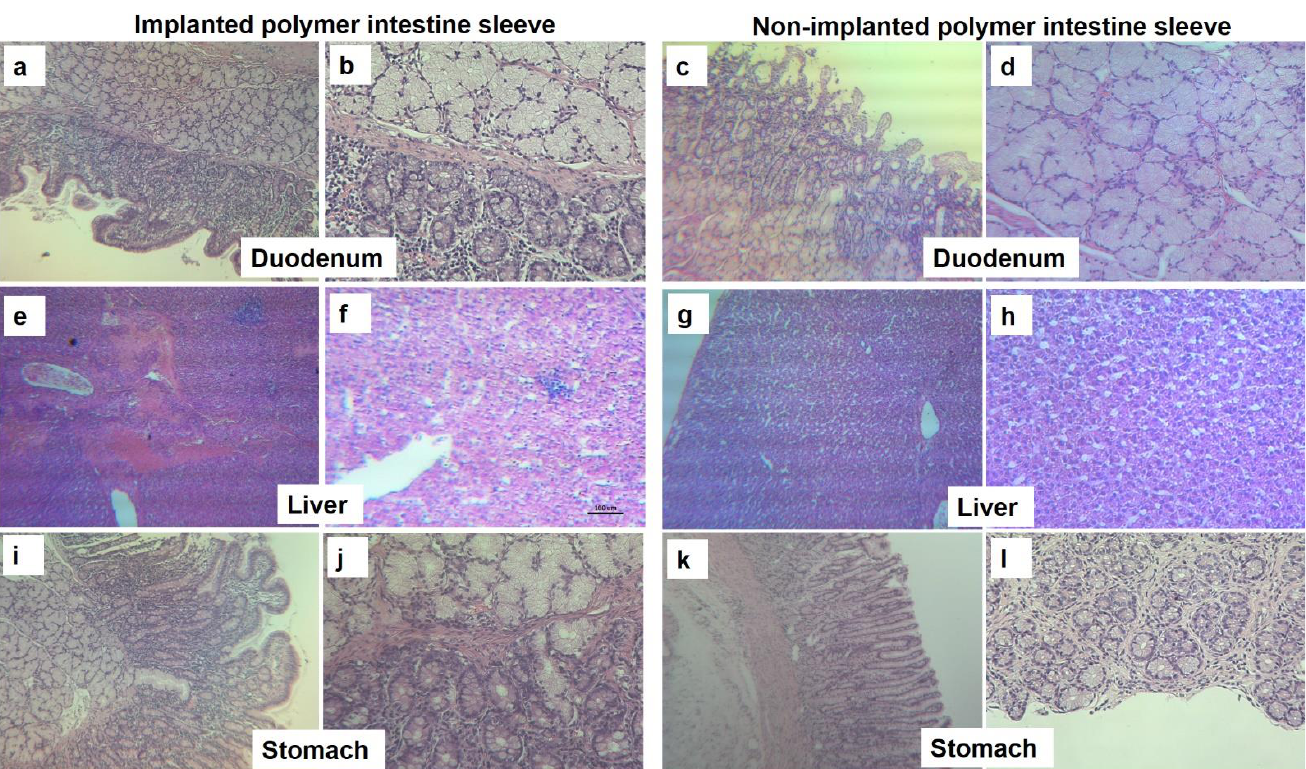
designed film coater. Figure S2. Raman spectroscopy peak splitting schematic diagram. Figure S3. Cytotoxicity test of PVDF with different process methods. Table S1. Reference of PVDF FTIR characteristic peak. Table S2. Reference of PVDF Raman characteristic